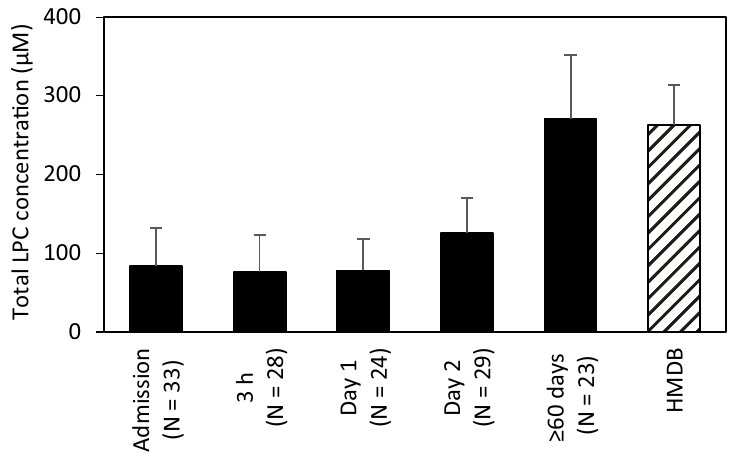
Fig 2. Mean LPC concentration dynamics in sera of the patients with CAP and comparison with values retrieved from the Human metabolome database